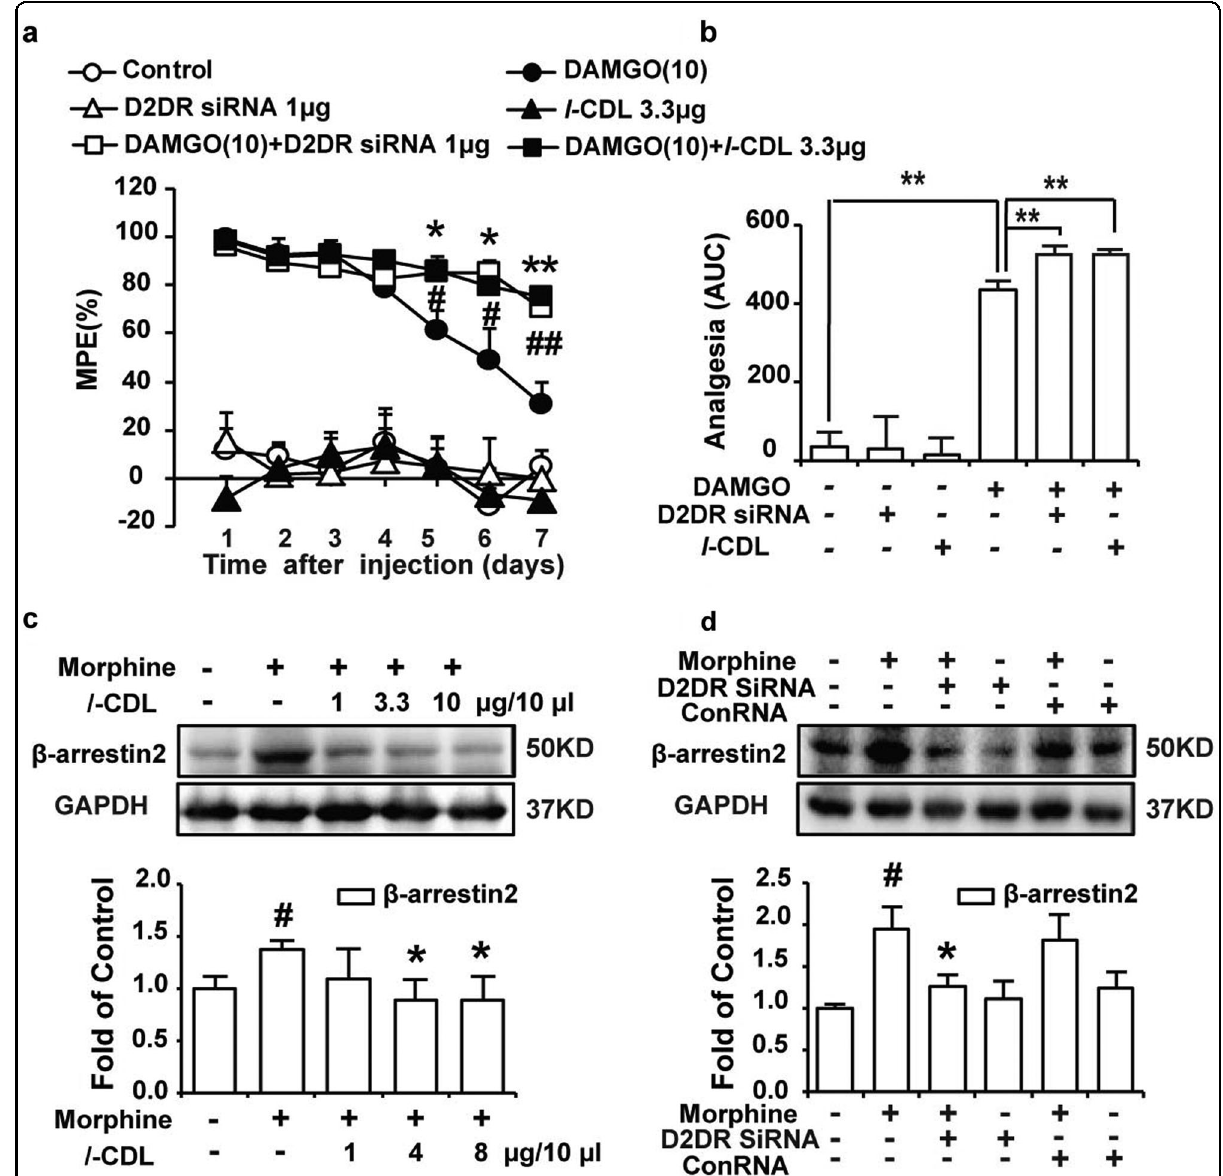
Fig. 4 l-CDL antagonizes spinal D2DR to attenuate morphine tolerance in mice in a MOR-dependent manner. a , b Intrathecal administration of l- CDL and the D2DR siRNA attenuated tolerance induced by the chronic DAMGO treatment. Data are presented as means ± SE. n = 12, # P < 0.05, ## P < 0.01, comparison between groups treated with the combination of l -CDL and DAMGO and DAMGO alone; * P < 0.05, ** P < 0.01, comparison of groups treated with the combination of the D2DR siRNA and DAMGO and DAMGO alone. Mice were examined daily using the tail- fl ick assay. Data are presented as percentages of the maximal possible effect (% MPE). c , d The expression of β -arrestin2 was upregulated in the spinal cord, and the intrathecal administration of both l -CDL and the D2DR siRNA decreased the upregulation of β -arrestin2 expression in the spinal cord. Data are presented as means ± SE. n = 4, # P < 0.05, ## P < 0.01, compared with the vehicle; * P < 0.05, ** P < 0.01, compared with the morphine